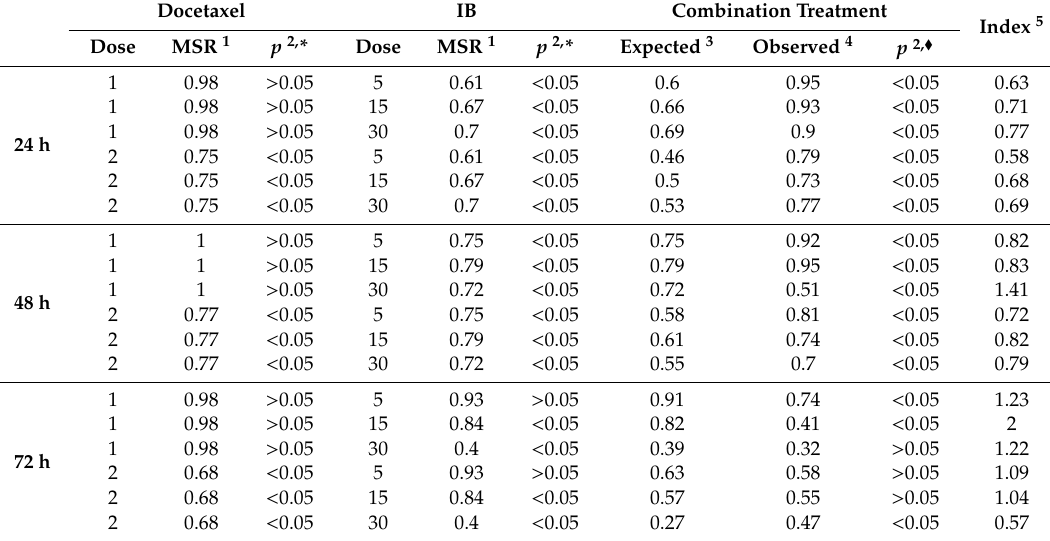
Table A6. Analysis of synergy between IB and DOCE calculated by survival rate for DU 145